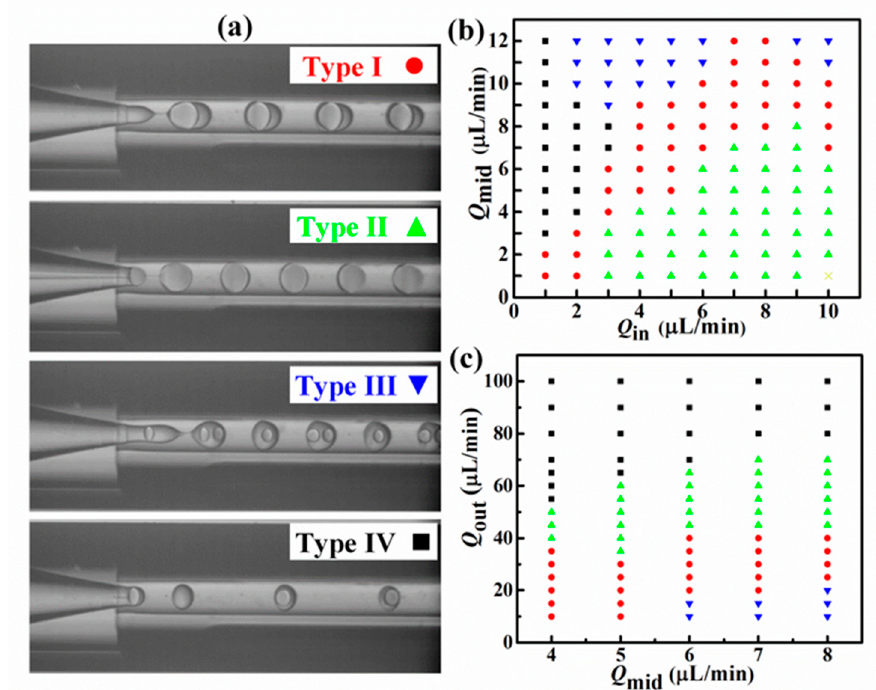
Figure 2. Double-emulsion droplets formation in a capillary microfluidic device. ( a ) Four types of droplet formation patterns marked with Type I (red circle), Type II (green triangle), Type III (blue inverted triangle), and Type IV (black square), denoting normal monodisperse double-emulsion droplets, double-emulsion droplets with an ultra-thin shell, more than one type of inner droplet encapsulated in one droplet, and one or none inner droplets encapsulated in one droplet, respectively. ( b ) Diagram of droplet patterns varying with Q in and Q mid at constant Q out = 30 µ L / min. ( c ) Diagram of droplet patterns varying with Q mid and Q out flow rates at ( Q mid − Q in ) = 1 µ L / min.